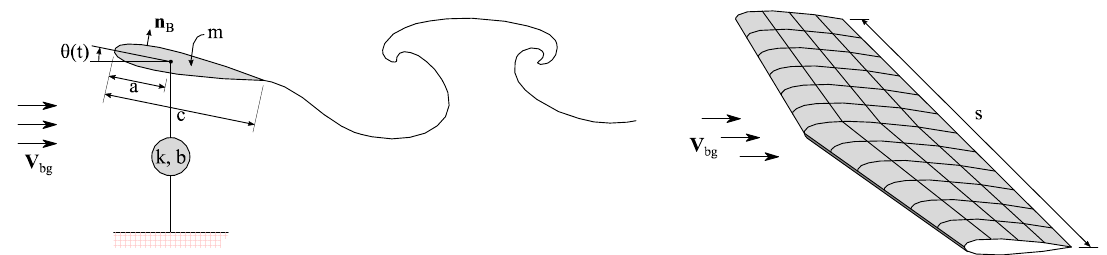
Figure 1. Schematic of the semi-activated flapping foil marine energy extracting device. The foil is attached to a power take-off (PTO) modeled by a damper and a spring.